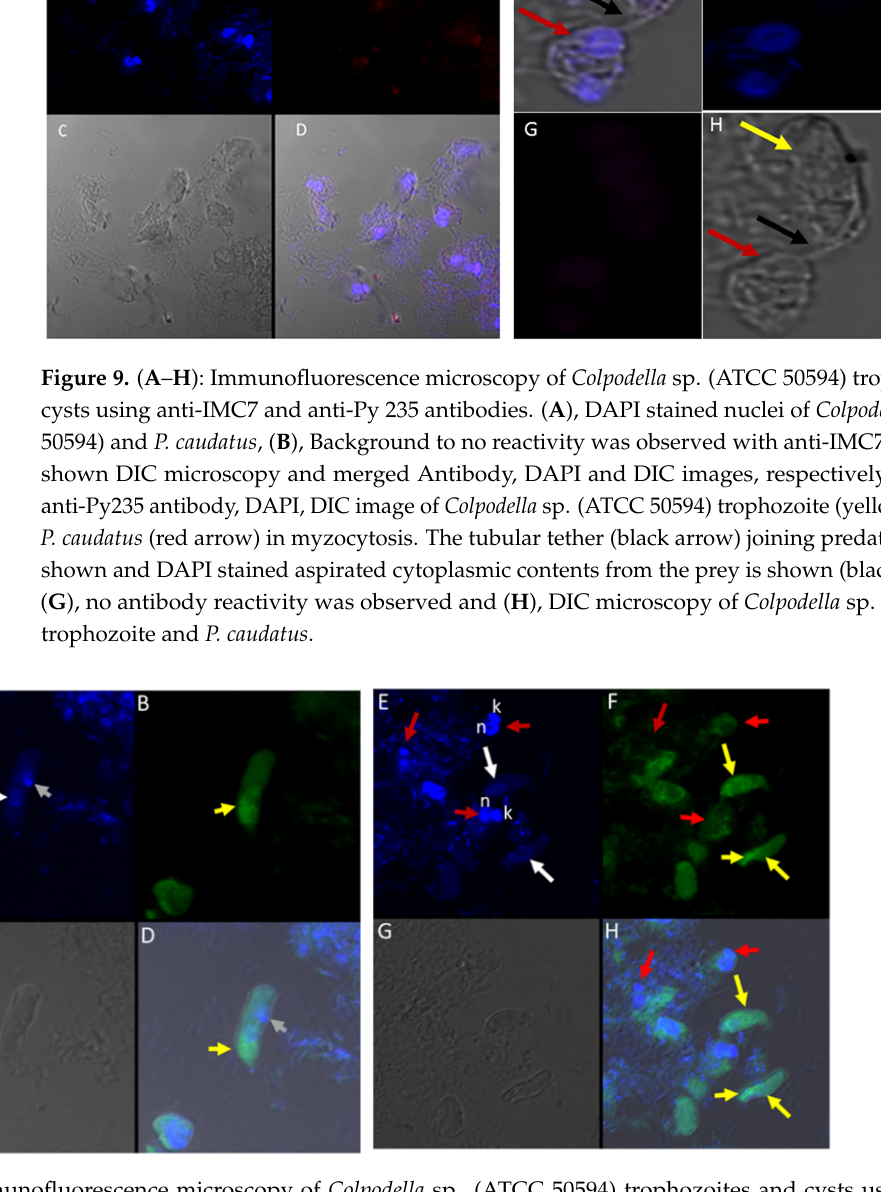
Figure 11. ( A – H ): Immunofluorescence microscopy of Colpodella sp. (ATCC 50594) trophozoites and cysts using anti-EBA175 antibodies. ( A , E ); DAPI stained nuclei of Colpodella sp. (ATCC 50594) (white arrow) and P. caudatus trophozoites (red arrow) showing nucleus (n) and kinetoplast (k). ( B , F ); anti- EBA175 reactivity with single Colpodella sp. trophozoite and multiple trophozoites feeding on a sin- gle P. caudatus . Yellow arrowhead shows cluster of four Colpodella sp. (ATCC 50594) trophozoites. ( C , G ); show DIC microscopy of Colpodella sp. (ATCC 50594) and P. caudatus trophozoites. ( D , H ); Merged image of anti-EBA175, DAPI and DIC.